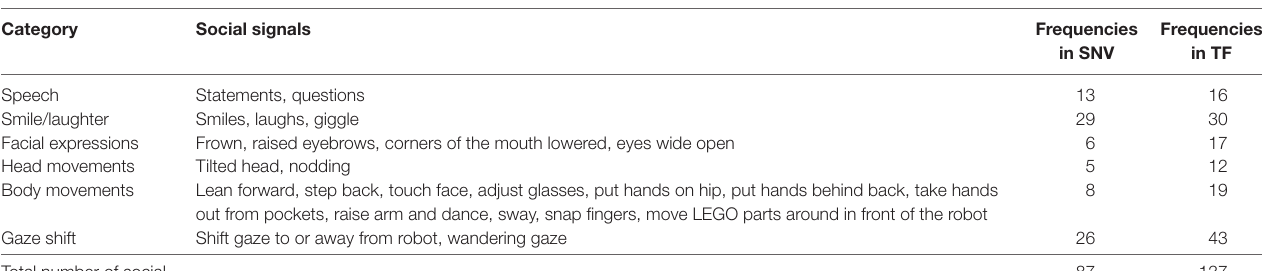
Table 7 | Overview on social signal categories and frequencies per error